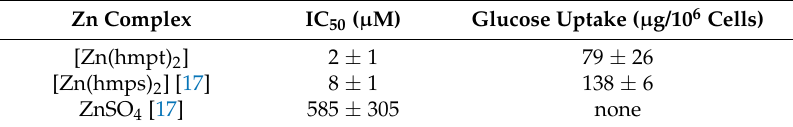
Table 1. IC 50 values of free fatty acid release and glucose uptake using 20 μ M Zn complexes.